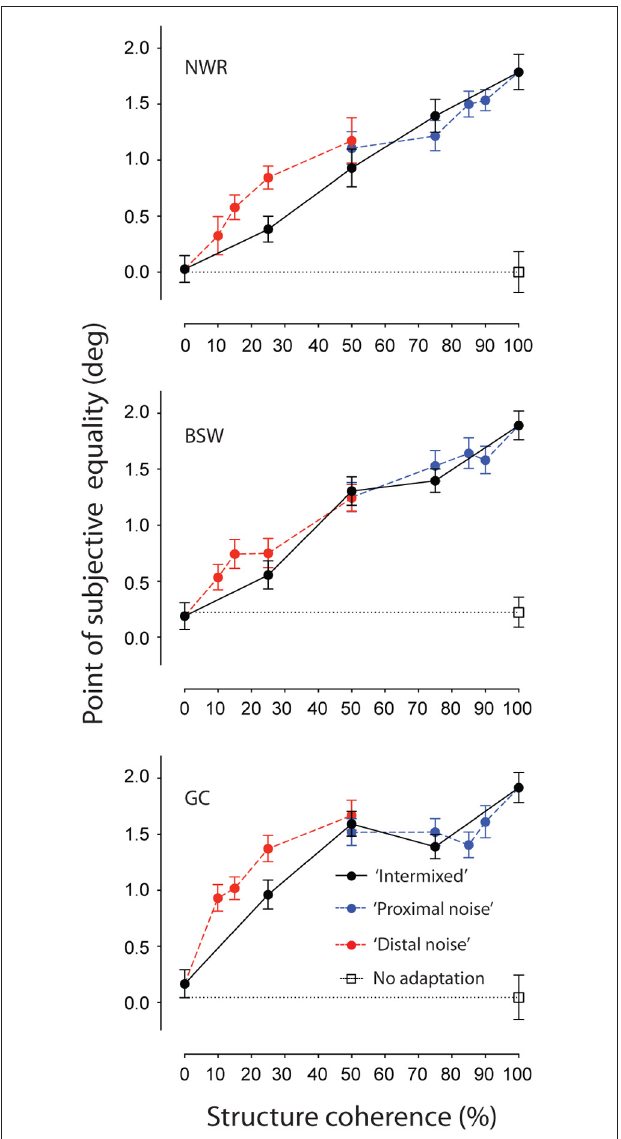
FIGURE 2 | Spatially remote TAEs-induced by adaptation to noisy concentric texture patterns with different spatial configurations. Points of subjective equality are plotted as a function of signal to noise ratio for three individual observers. Black filled symbols represent performance where randomly oriented noise elements were distributed across the texture pattern (see Figure 1B ). Red and blue symbols represent performance when noise elements were positioned inside ( Figure 1C ) or outside ( Figure 1D ) an annular region surrounding the test site, respectively. Unadapted (baseline) performance is shown by the unfilled black symbol. Error bars indicate ± 1 standard